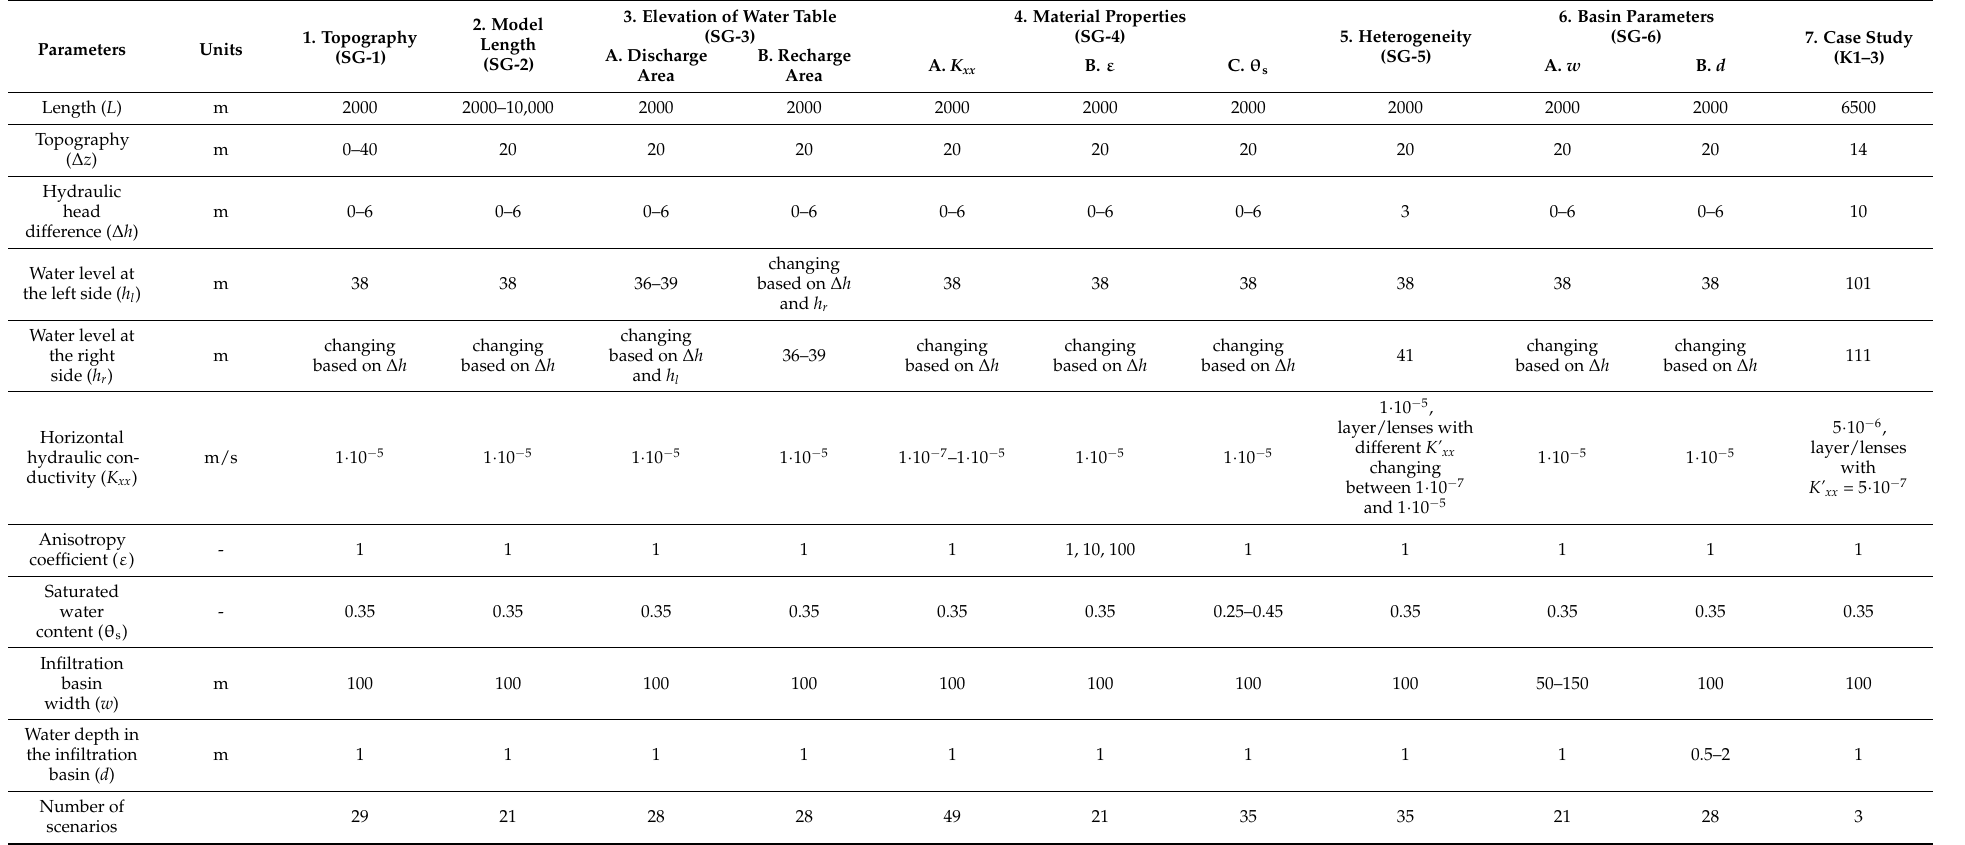
Table 1. Model scenarios with the studied parameters for the theoretical simulations (1–6) and the case study